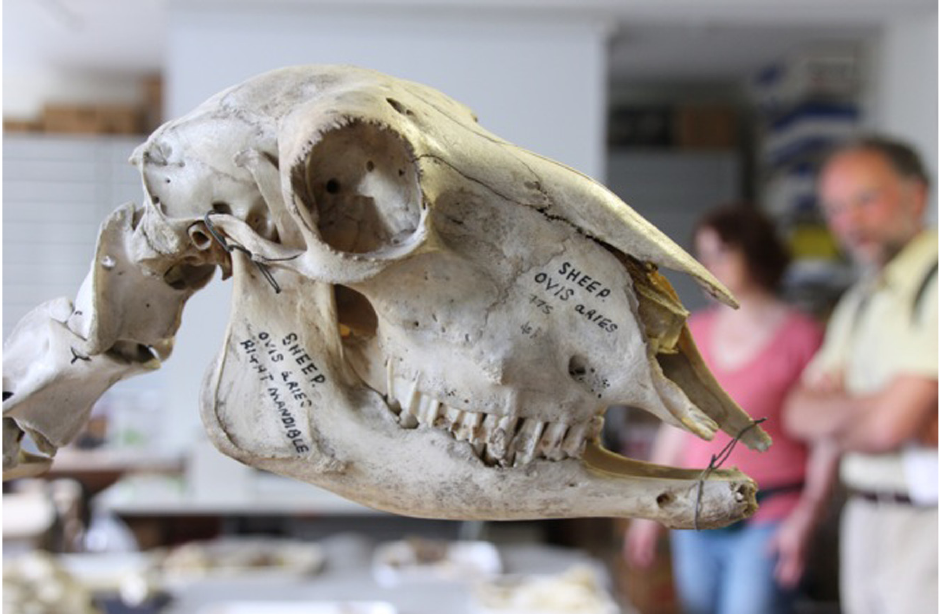
Fig. 1: The skull of a sheep from the Institute’s extensive reference collection of faunal remains from around the world (photo: Lisa Daniel).